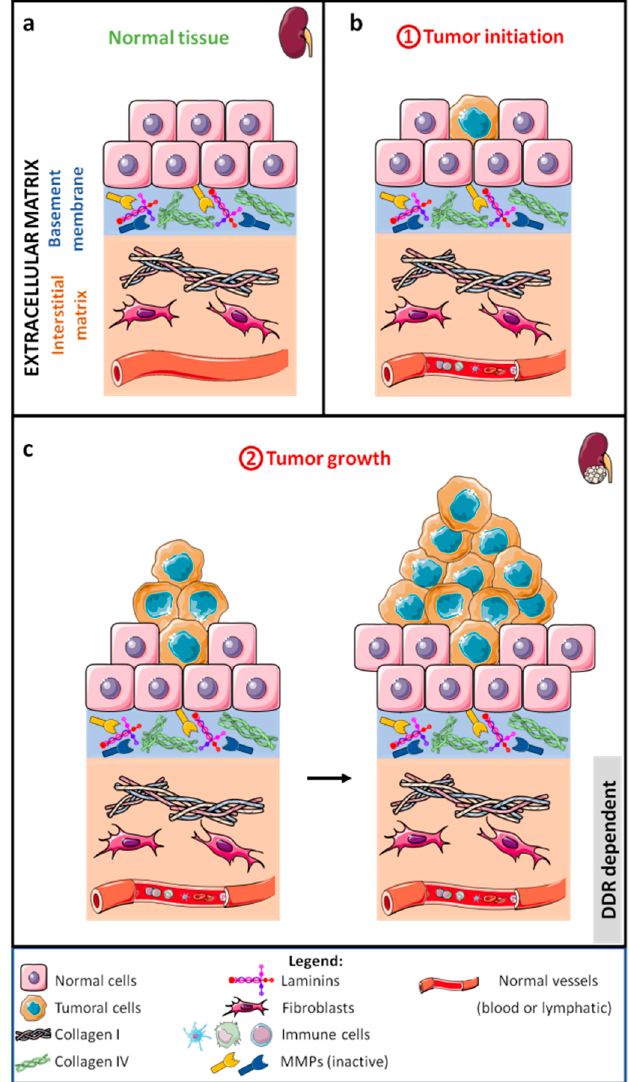
Figure 1. Schematic representation of normal tissue ( a ), carcinoma initiation ( b ), and initial stages of carcinoma development ( c ).